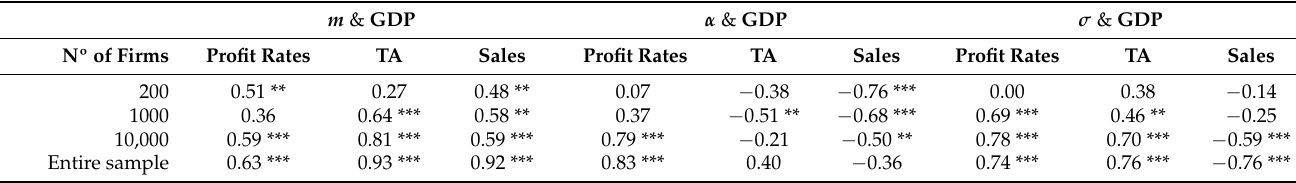
Table 4. Pearson correlation coefficient between the time series of the estimates of m , α and σ with the time series of GDP growth rates. *** denotes significance at the 1% level; ** denotes significance at the 5% level; * denotes significance at the 10%